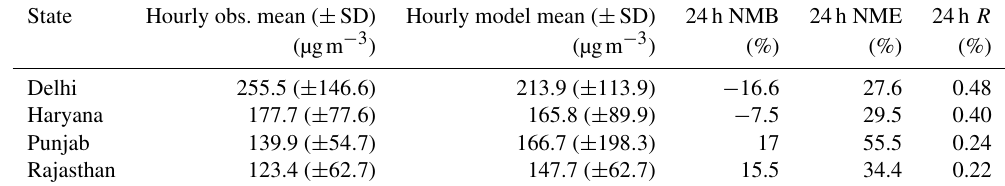
Table 3. Mean ( ± standard deviation), normalized mean bias (NMB), normalized mean error (NME), and Pearson’s correlation co- efficient ( R ) averaged for all CPCB stations in different states during November 2017. Model values are for the base scenario (FINN_VIIRS_7Xpeiod2). Mean values are for hourly data, while NMB, NME, and R relate 24h averaged